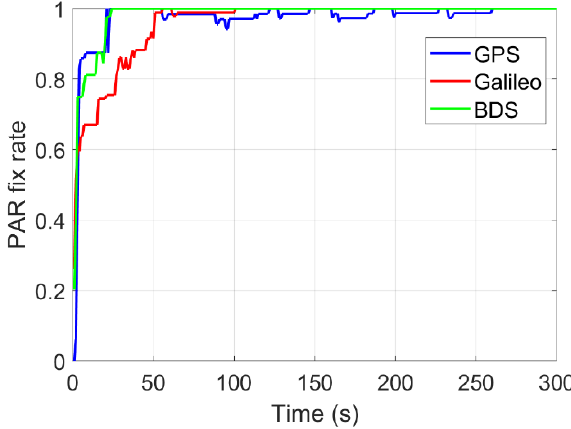
Figure 3. Fix rate of the PAR for L1/L5 GPS, Galileo and BDS using Network